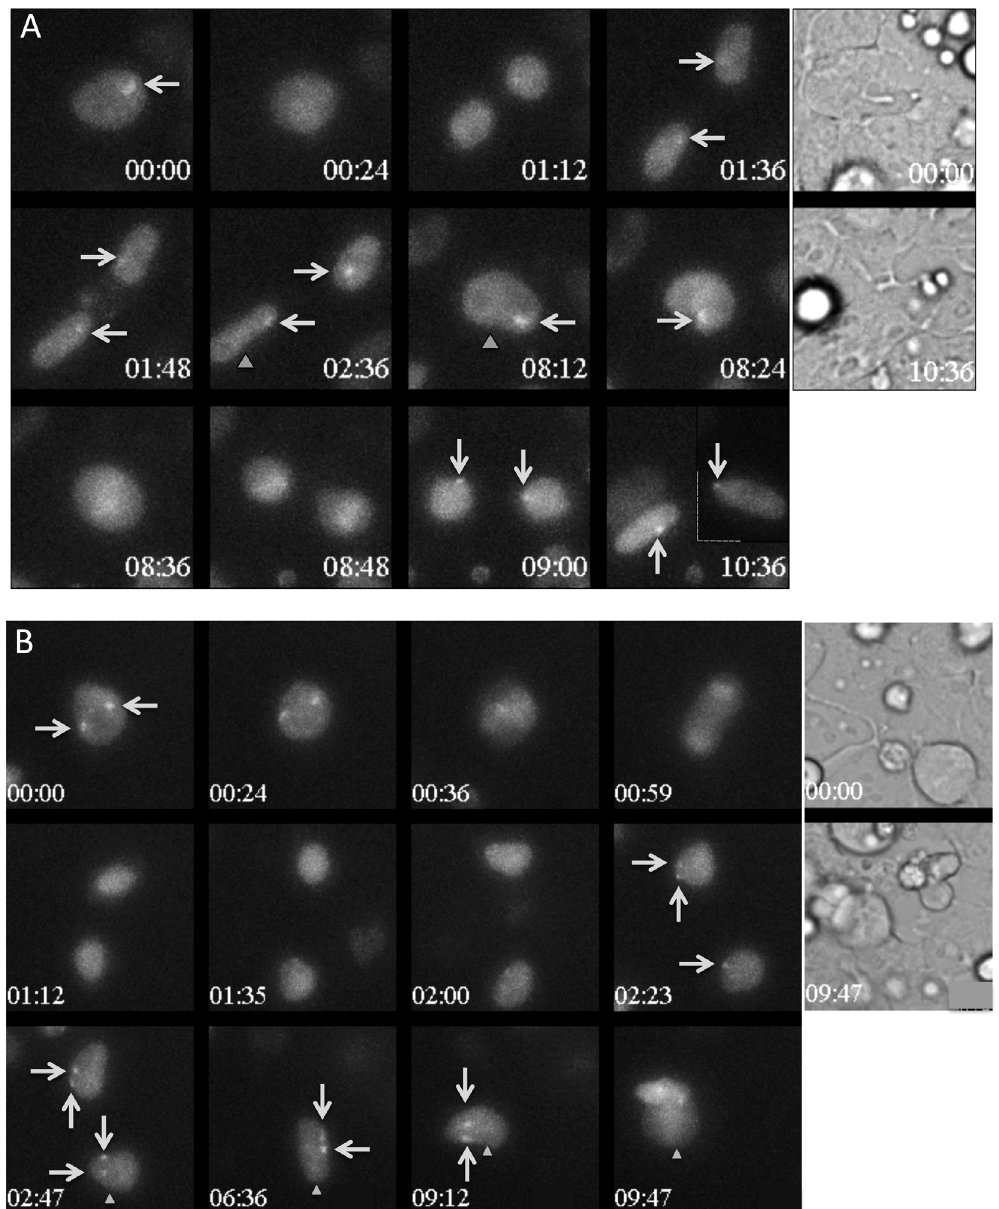
Fig. 3. Live-cell imaging showing that the recruitment of Ezh2-Venus to the nascent inactive X chromosome is lost during mitosis and is restored progressively during interphase. In both A and B, the 12 left panels show wide-field fluorescent maximum projection images of Z-stacks in the Venus channel at selected time points during differentiation of the Z8.1 ES cell line. Time is indicated relative to the start of the sequence shown (hours: minutes). The white arrows point to the Ezh2-Venus accumulation foci. When necessary, gray triangles unambiguously identify the cell, which can be followed in two successive panels. Transmission images at the start and the end of the sequence are shown in the two panels on the right. It was verified that the nuclei had been fully imaged in Z by examining individual plans of the Z-stacks. Full time-lapses corresponding to these stills are shown in S2 Video and S3 Video. A) The initial time in this sequence corresponds to 50 hours and 50 minutes after shifting from 2i plus LIF to EpiLCs culture conditions. Daughter nuclei lacked fluorescent Ezh2-Venus accumulation for 1 hour after the first mitosis, and for only 12 minutes after the second mitosis. The dashed line at time 10:36 indicates that the image of one of the cells was digitally treated to bring it closer to its sister. B) The initial time shown in this sequence corresponds to 53 hours and 25 minutes after shifting from 2i plus LIF to EpiLCs culture conditions. After the separation of the daughter cells, the nuclei lacked a domain of Ezh2-Venus accumulation for 1 hour and 12 minutes. The daughter cell in the lower region of the image then started to display a single fluorescent domain and only then regained a second domain (arrows).